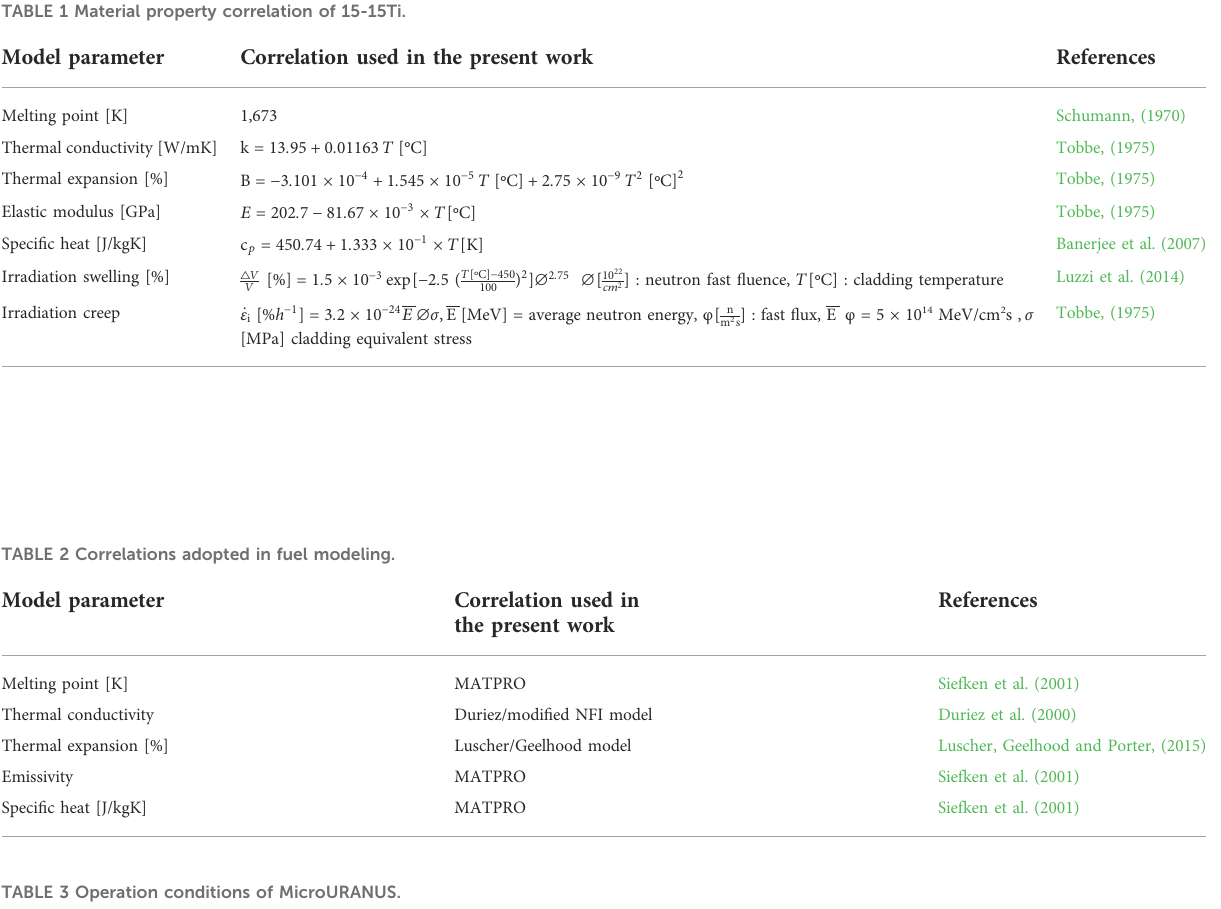
TABLE 1 Material property correlation of 15-15Ti.